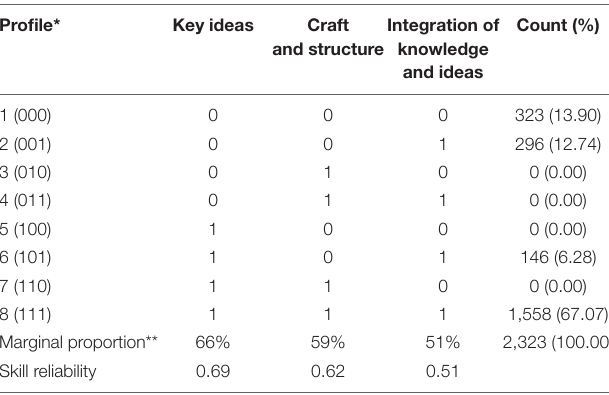
TABLE 3 | Students’ mastery status of reading skills and reliability of each